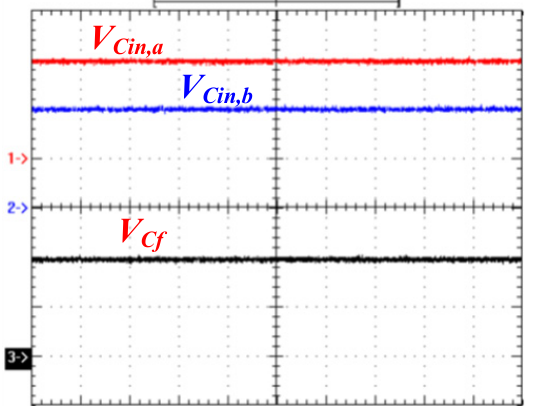
Figure 11. Experimental waveforms of V Cin,a , V Cin,b and V Cf at 800 V input and 100% rated power